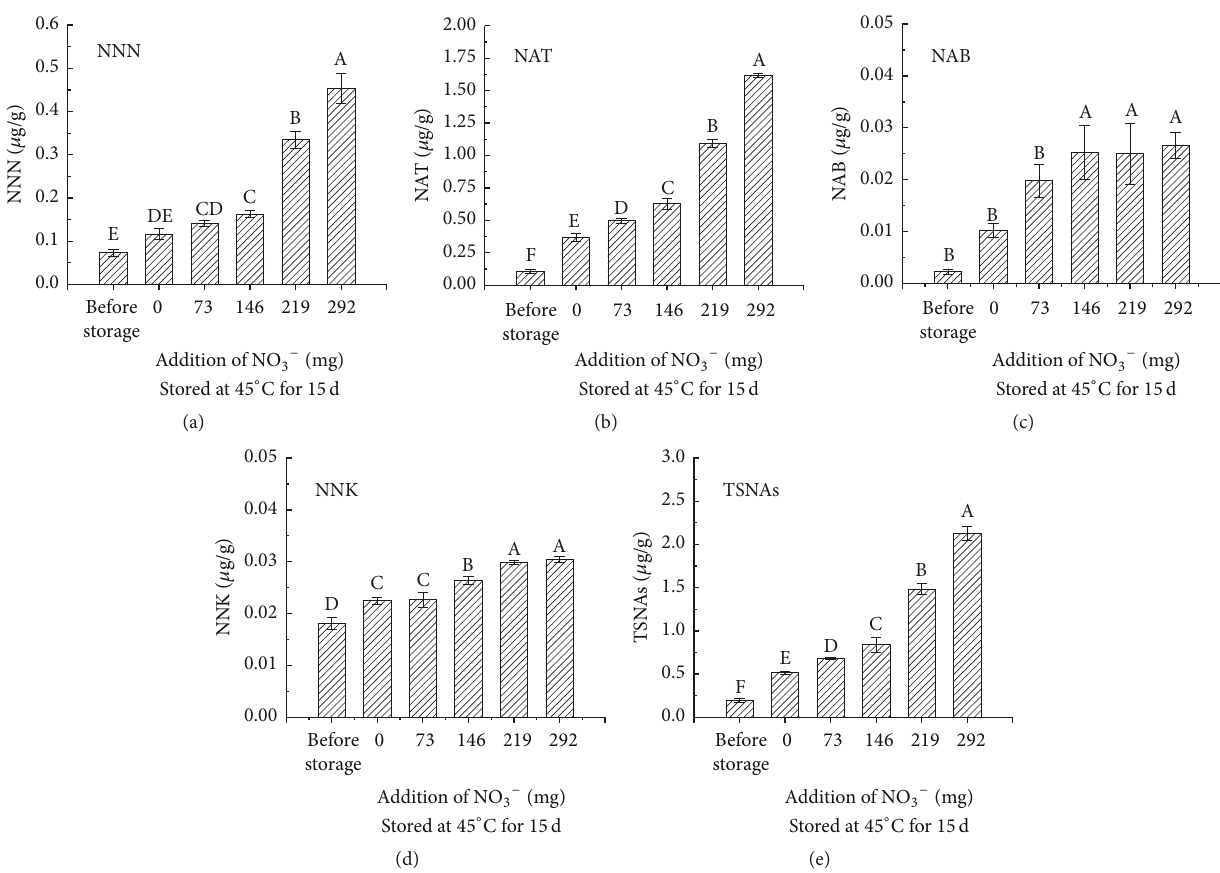
Figure 3: Effects of added nitrate on TSNAs formation in flue-cured tobacco stored at 45 ∘ C for 15d. Note . For all experiments, each value represents the mean of three independent samples. Uppercase letters indicate significant differences between the treatments at 𝑃 < 0.05